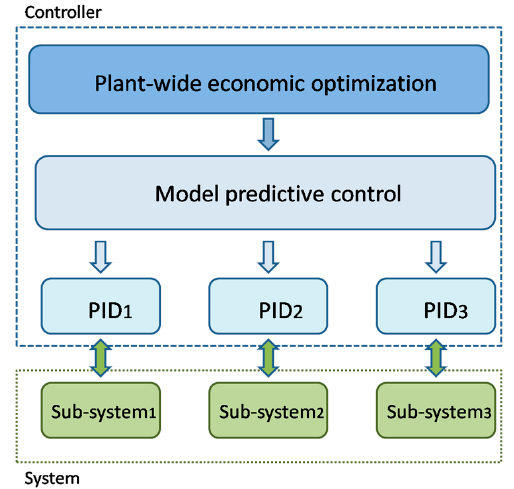
Figure 1. Schematic representation of hierarchical control.